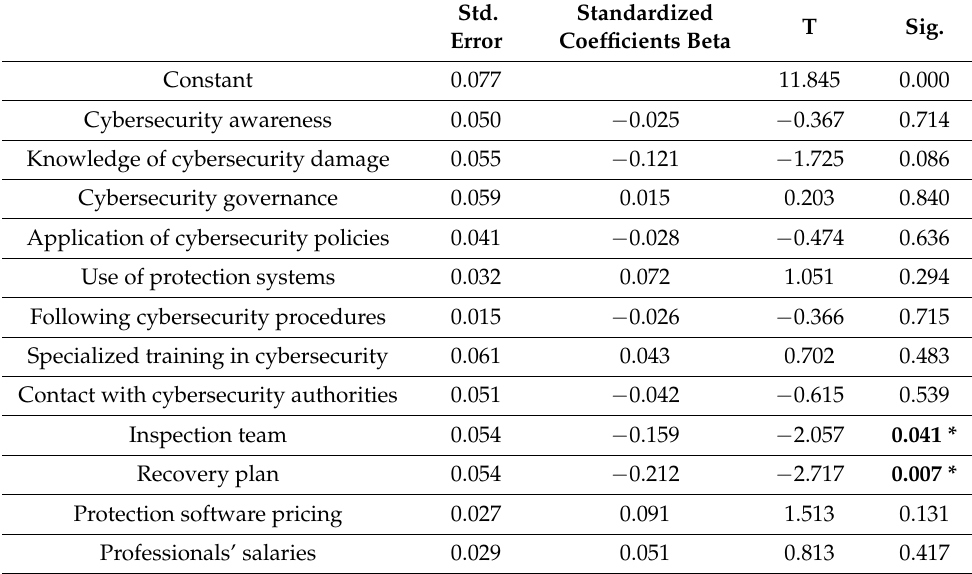
Table 5. Model coefficients (financial damage).